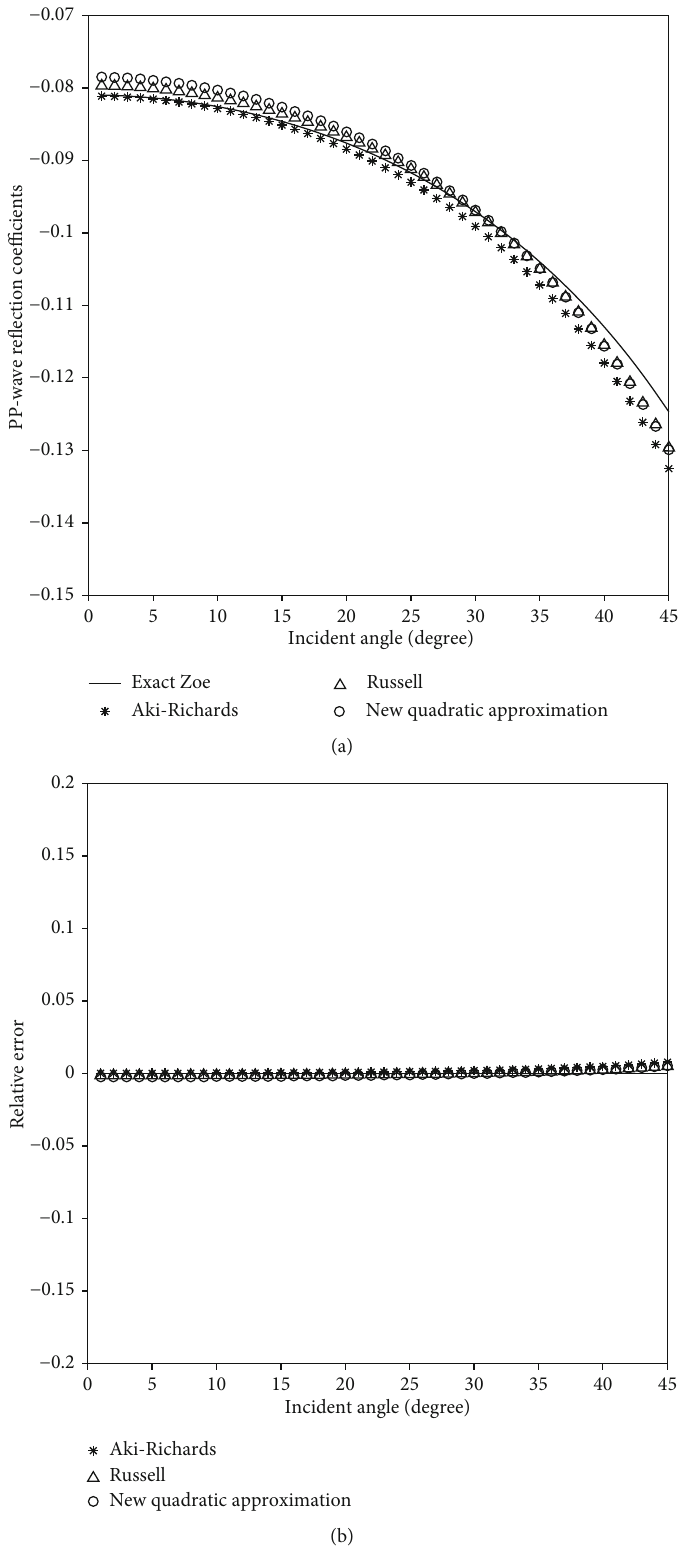
Figure 1: Comparison of re fl ection coe ffi cients calculated by the exact Zoeppritz equations, Aki – Richards approximation, Russell linear approximation, and the new quadratic approximation of model 1. (a) Re fl ection coe ffi cients calculated by di ff erent formulas; (b) di ff erence of the re fl ection coe ffi cients between the exact Zoeppritz equations and their three approximations,